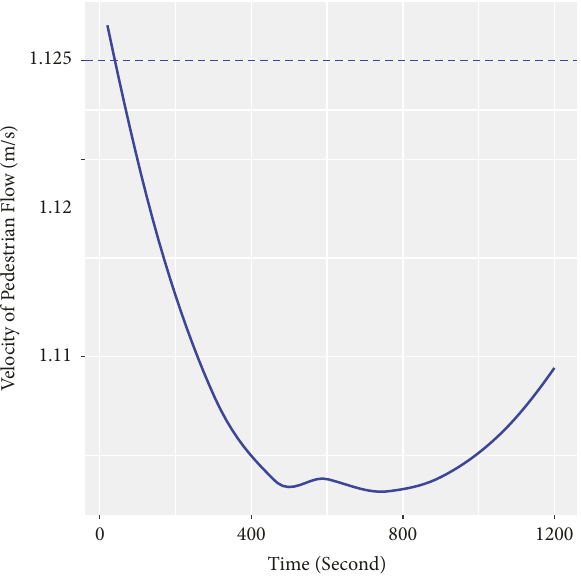
Figure 7: Transformation of the Velocity of Pedestrian Flow over time (The dashed line represents measured data in the real situation and the fitting curve shows experimental data in the